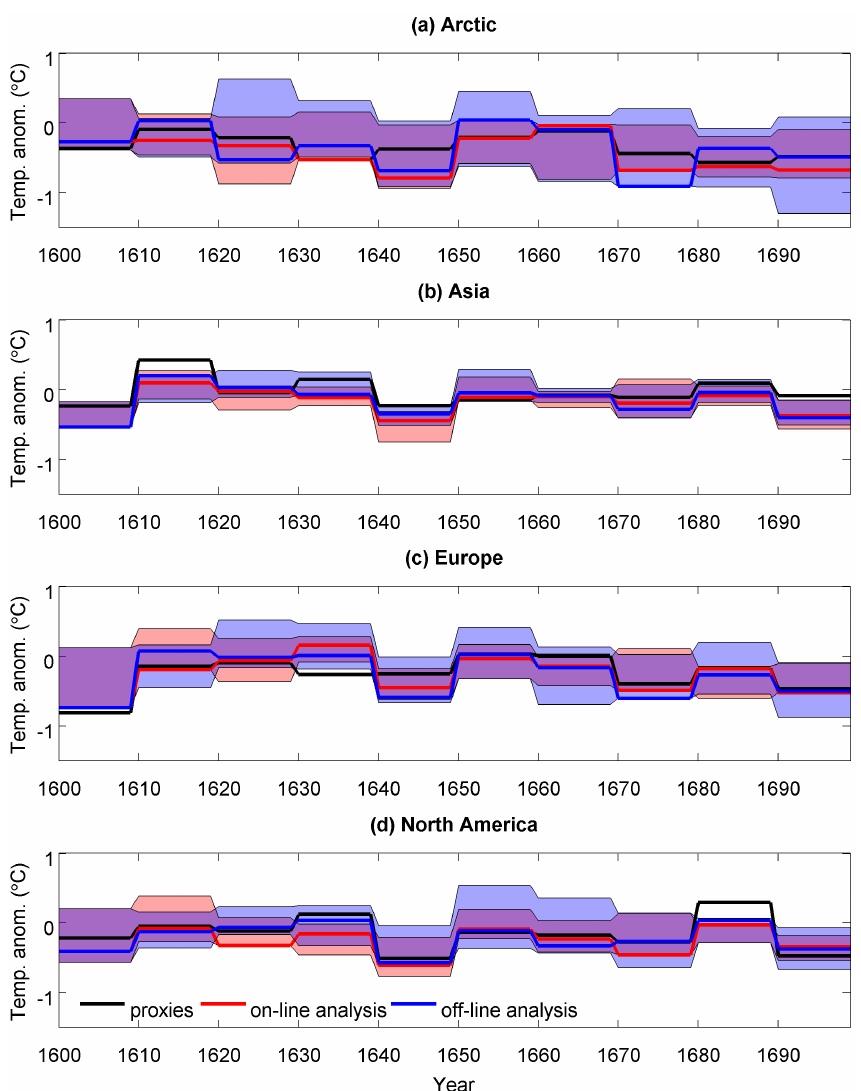
Figure 2. Continental decadal mean temperature anomalies w.r.t. the AD850–1850 mean in the Northern Hemisphere for the 17th century, for the on-line (red shading) and off-line (blue shading) ensemble members, the on-line (red line) and off-line DA analysis (blue line), and the proxy-based reconstructions (black